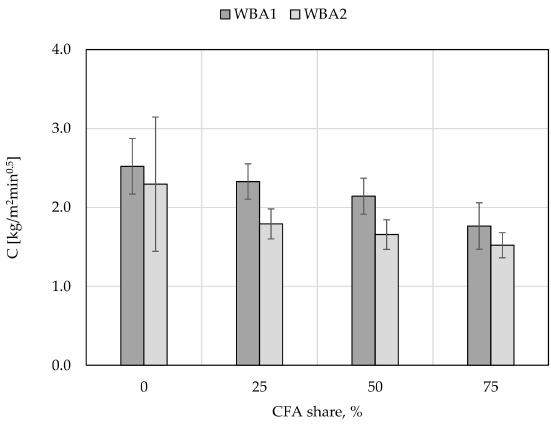
Figure 11. The coefficients of water